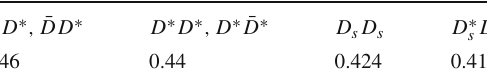
Table 9 The values of ν i for different charmonium-like